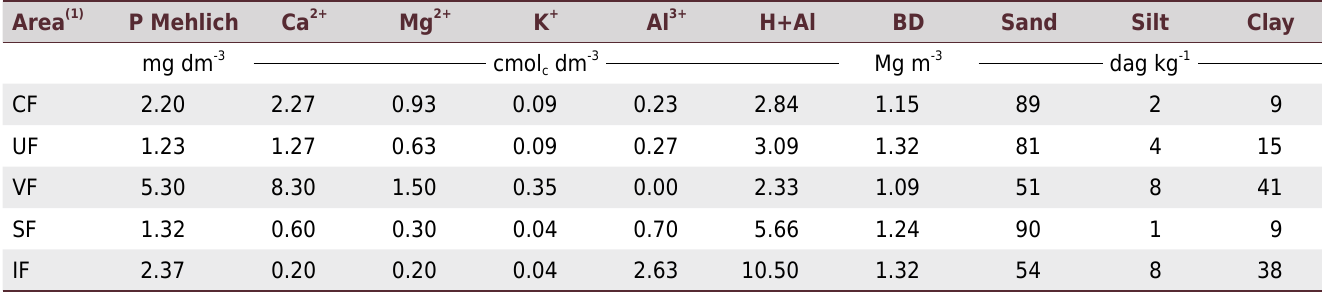
Table 2. Chemical and physical properties of the A horizon soil samples (n =3) Area